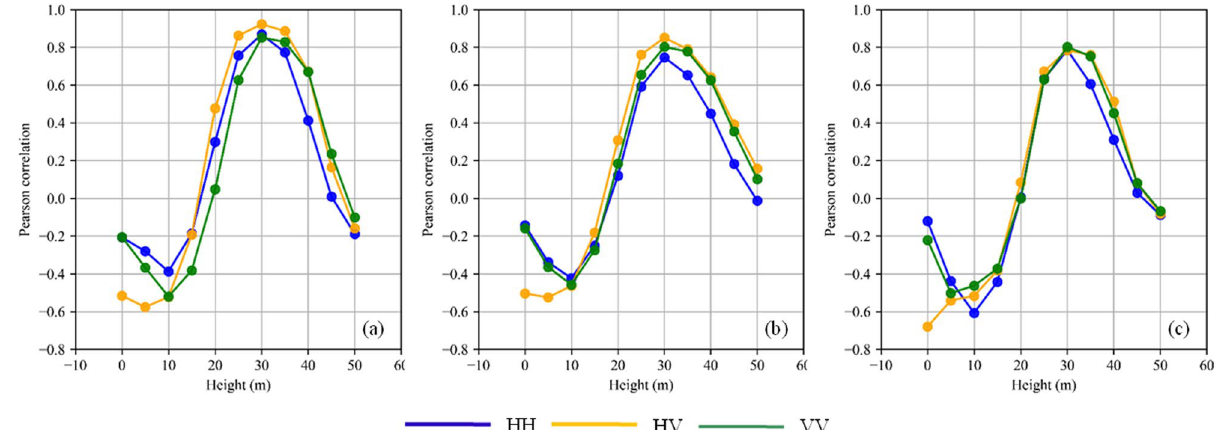
Figure 3. The Pearson correlation of TomoSAR backscattered power associated with different heights reference AGB for different polarizations at 4 ha resolution ( a ) BP, ( b ) Capon, and ( c ) MUSIC . Blue, orange, and green represent HH, HV, and VV